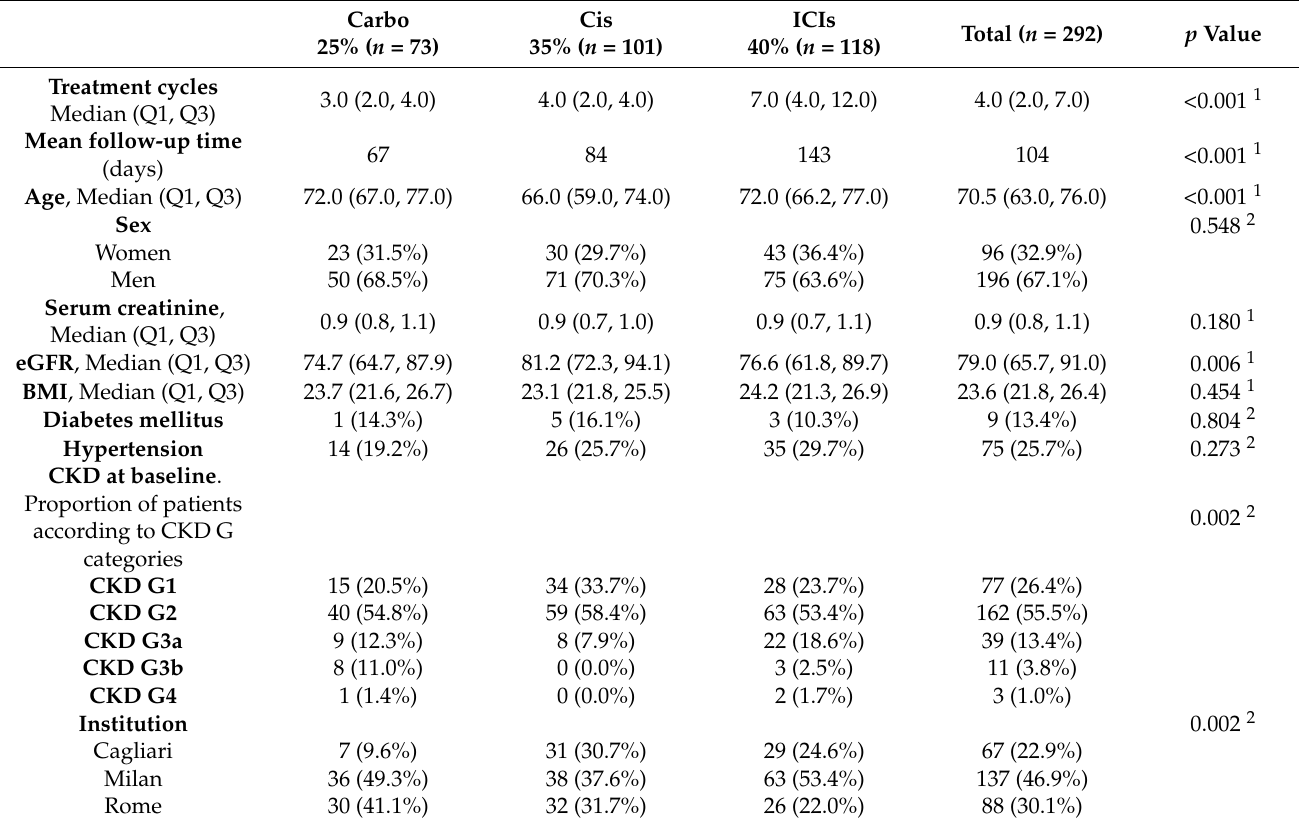
Table 2. Baseline descriptive population characteristics. 1 : Kruskal–Wallis test; 2 : Pearson’s Chi- square test.